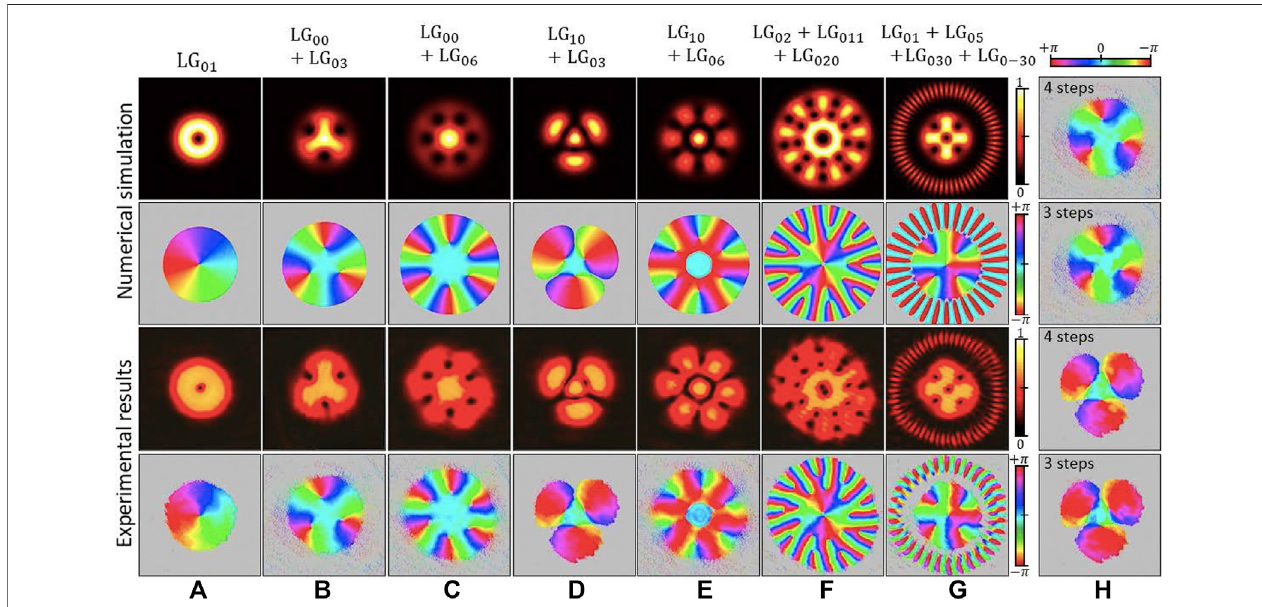
FIGURE4| RealizationofdifferentsuperpositionsofLGmodes: (A) LG 01 (B) LG 0-1 (C) LG 00 +LG 06 , (D) LG 10 +LG 03 , (E) LG 10 +LG 06 , (F) LG 02 +LG 0,11 +LG 0,20 , (G) LG 01 + LG 05 + LG 0,30 + LG 0,-30 . First and second rows show numerical simulations of the intensity and phase distributions. Third and fourth rows show the corresponding experimental results. (H) Experimental phase distributions for the superpositions LG 00 + LG 03 and LG 10 + LG 03 (cases (B) and (D) respectively) when PSI with 4 and 3 steps are